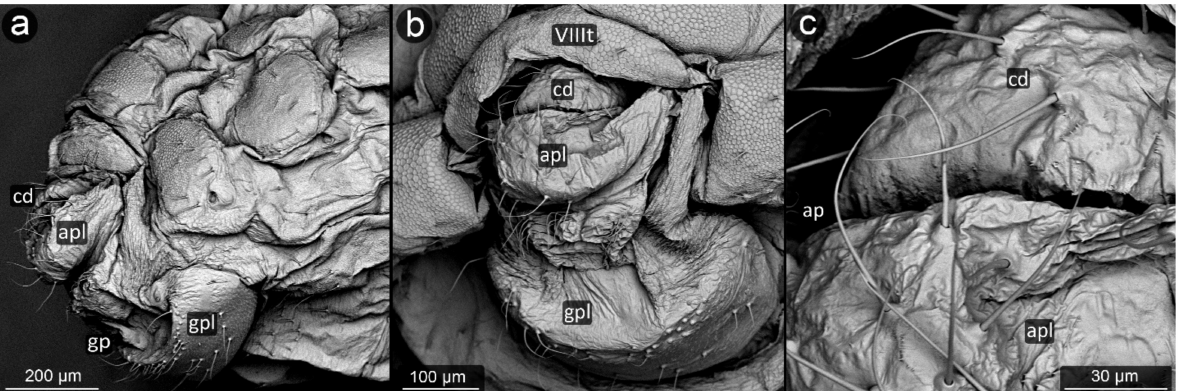
Figure 4. Perianal structure of Prociphilus bumeliae in SEM; ( a )—lateral view, ( b )—rear view, ( c )— close-up of the cauda surface and anal